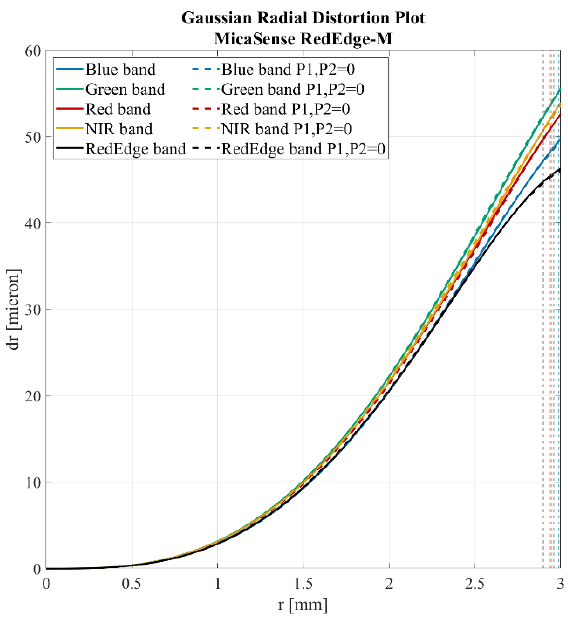
Figure 5: Gaussian radial distortion plot for each band Finally, the correlation matrices should be analysed. As an example, the interior orientation correlation coefficients for the Blue band have been reported in table 4.